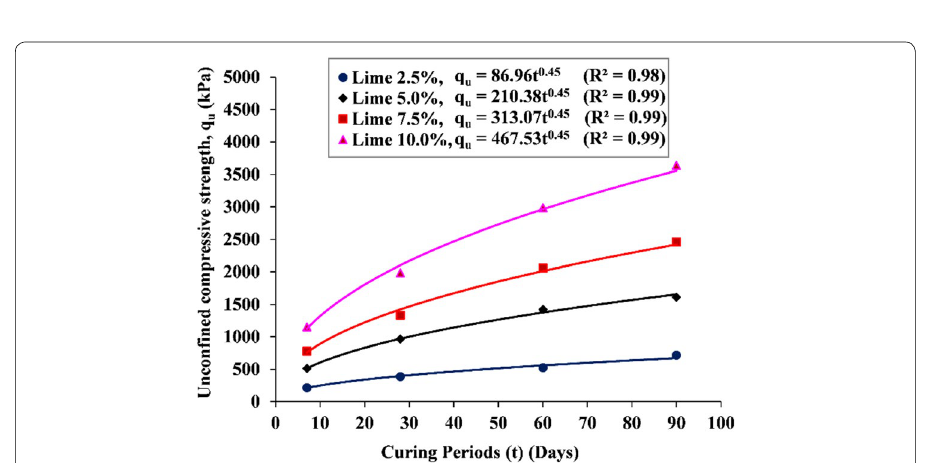
Fig. 6 Effect of lime content on UCS (q u ) with curing